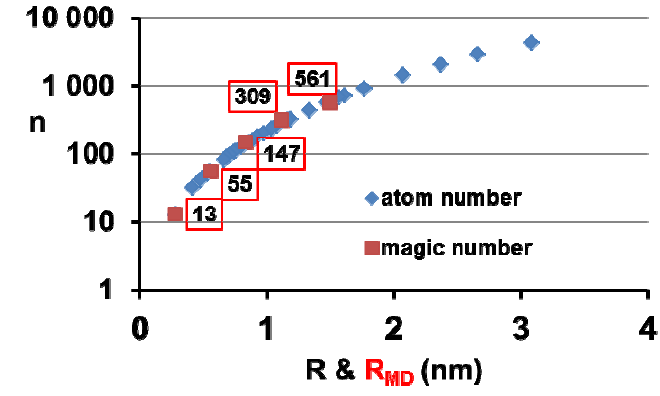
Figure 13. The critical atom number in blue versus the critical radius and R calculated by molecular dynamics simulations in red square